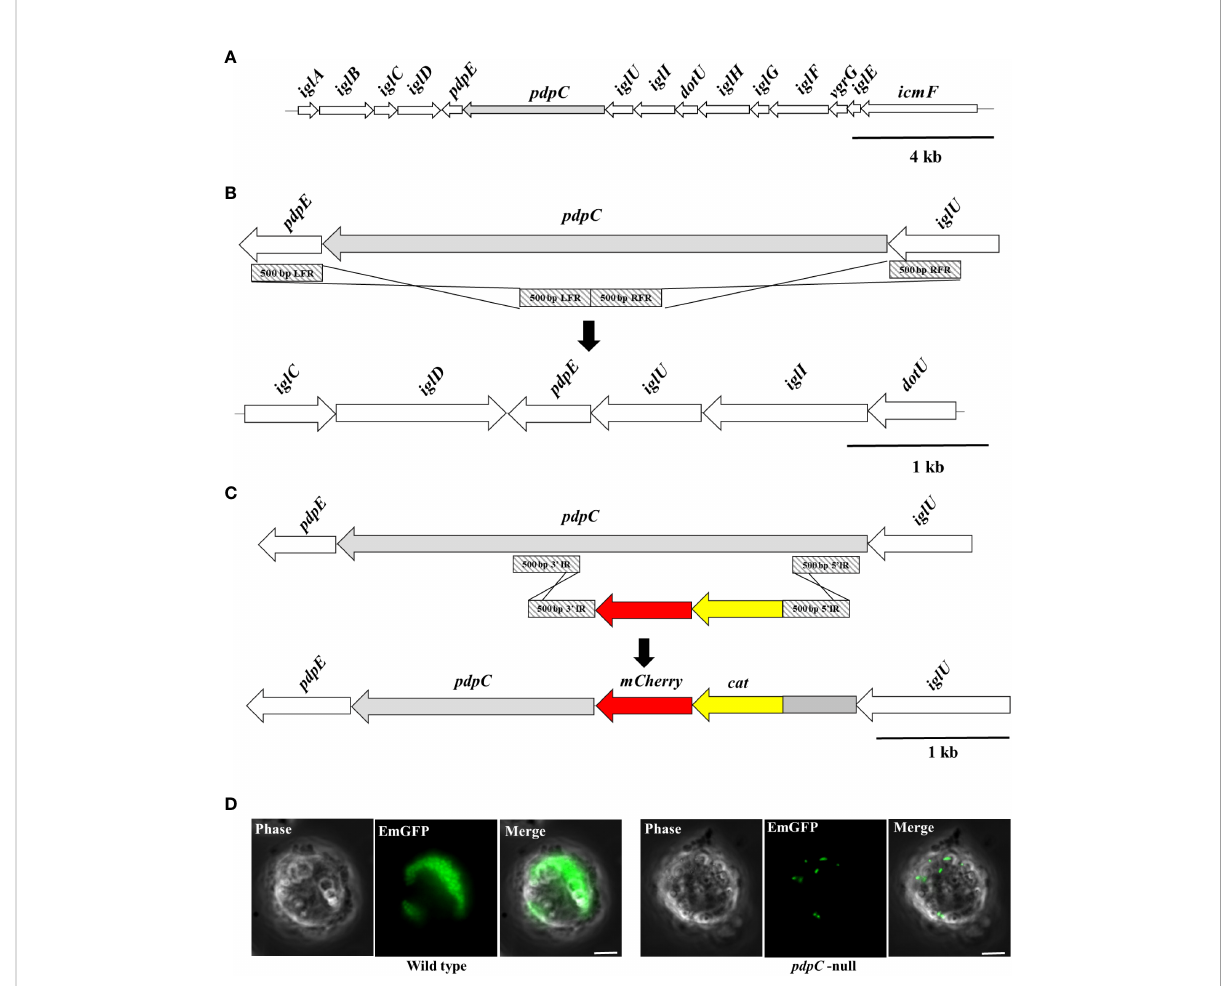
FIGURE 1 Construction of a pdpC -null strain of F. tularensis LVS. (A) The Francisella Pathogenicity Island (FPI). The FPI locus of F. tularensis , with pdpC shown in light grey. The FPI is duplicated in the F. tularensis chromosome. (B) Deletion of one copy of pdpC was achieved by homologous recombination of a deletion cassette (light grey diagonal stripes) created using 500 bp from either fl ank of pdpC . (C) The second chromosomal copy of pdpC was inactivated by insertion of a cat mCherry disruption cassette. (D) The pdpC -null strain is defective in intracellular replication. THP-1 human blood monocytes were incubated with fl uorescently labelled wild type (at left) and pdpC- null (at right) F. tularensis LVS at an MOI of 100 for 2 hours. Cells were washed to remove extracellular bacteria and incubated for a further 24 hrs. Epi- fl uorescence microscopy showed high levels of intracellular replication for the wild type but not for the pdpC -null